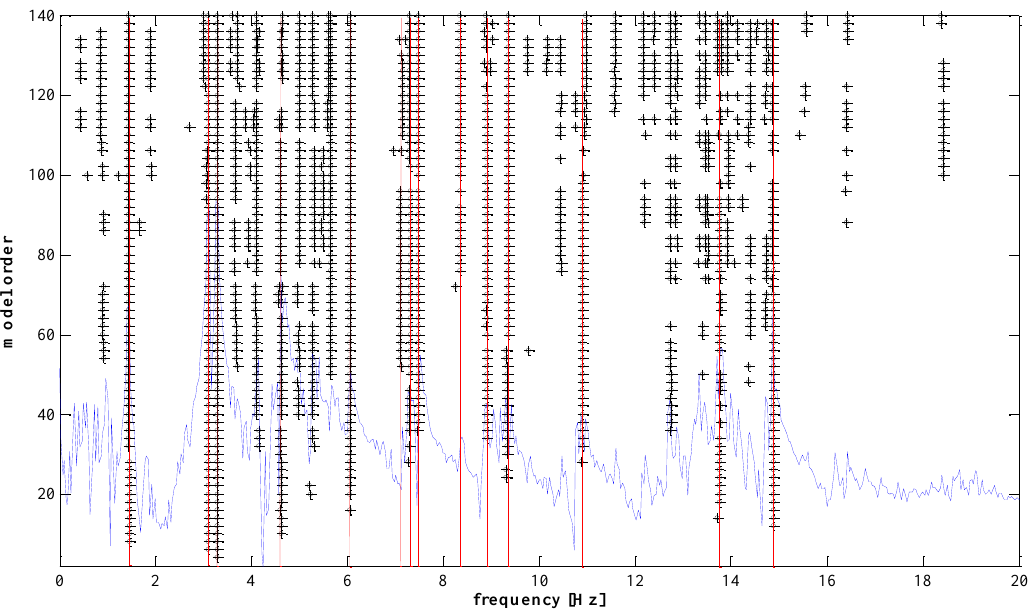
Figure 6. The stabilization diagram of setup 1 in the interval from 0 to 20 Hz.